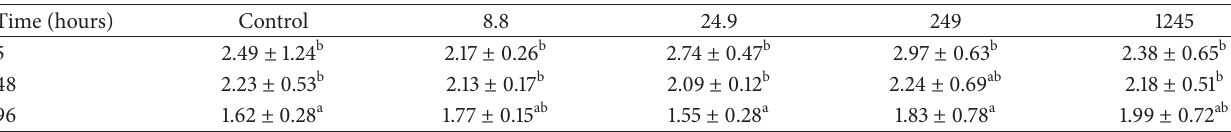
Table 1: Mean values ( ± SD) of hemolymph clotting time (minutes) of Litopenaeus vannamei exposed to four concentrations ( 𝜇 gL − 1 ) of